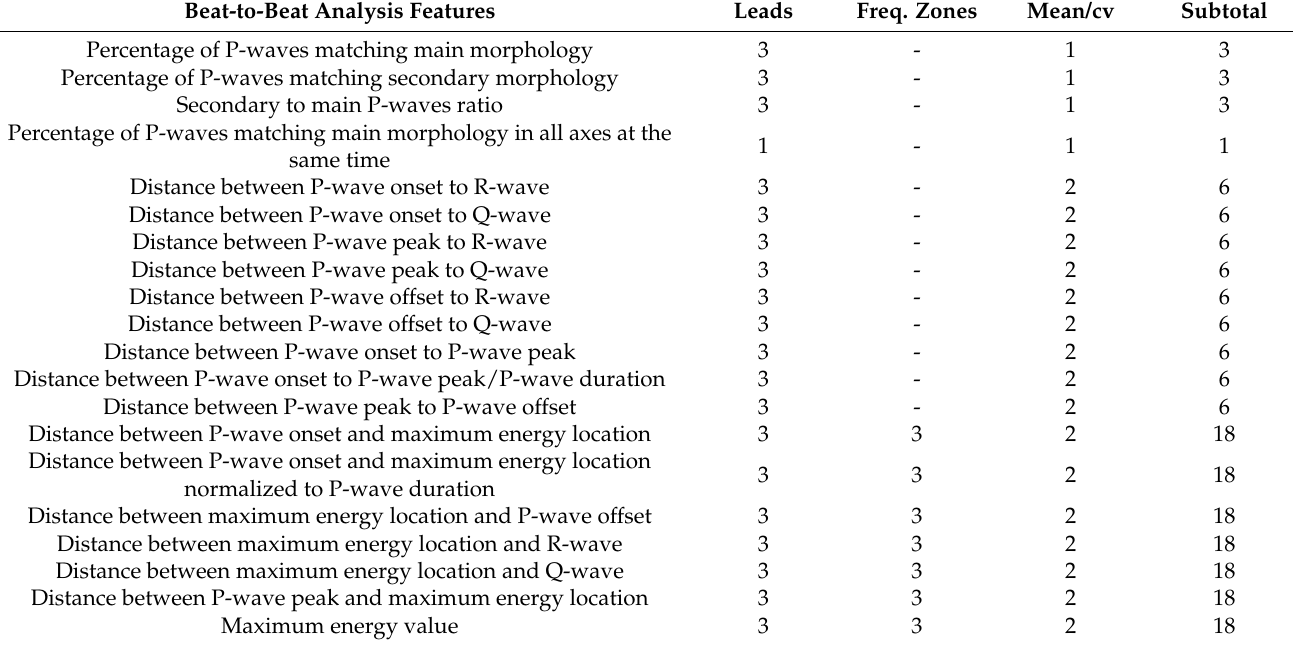
Table 2. Feature categories derived from beat-to-beat